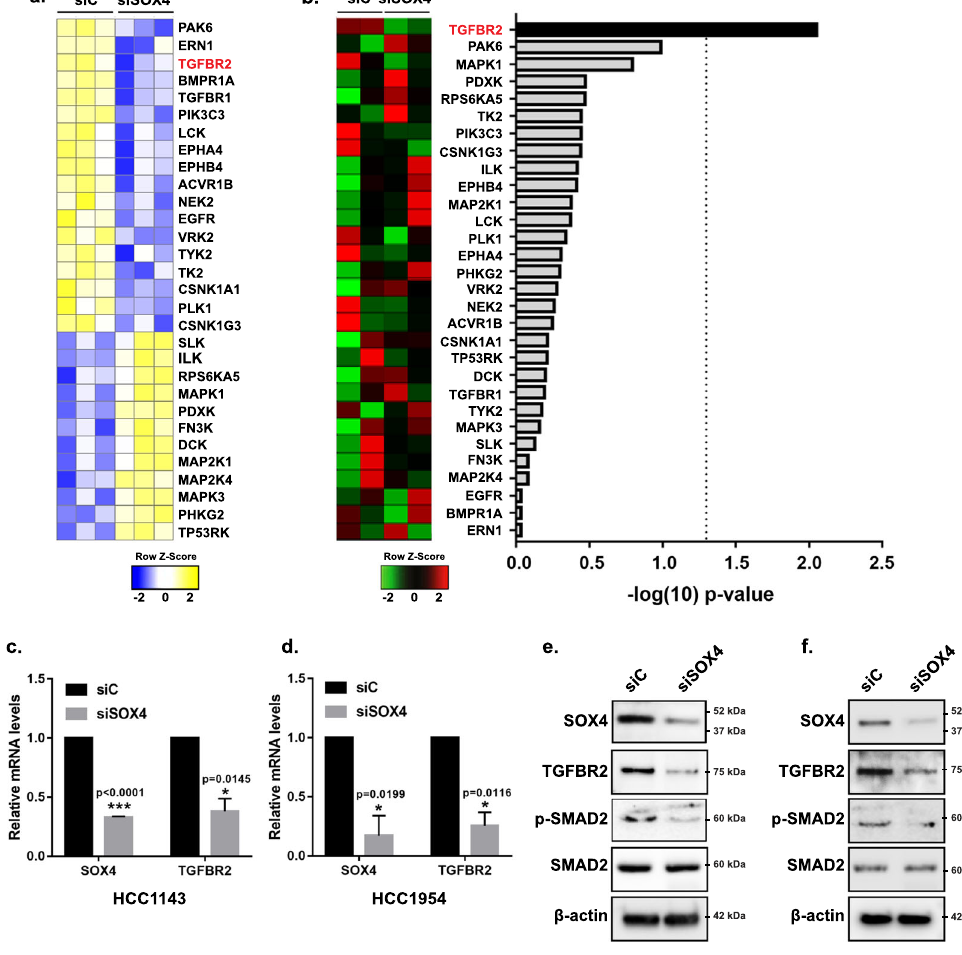
Fig. 2 TGFBR2 is a downstream target gene of SOX4. a Pro fi ling of the drug-able kinome by MIB/MS analysis in HCC1143 cells identi fi ed 18 kinases with signi fi cantly reduced expression and/or af fi nity for Type I kinase inhibitor bait ( p < 0.05) and 12 kinases with increased expression/ af fi nity following siRNA-mediated silencing of SOX4 ( n = 3, 96 h) relative to siControl-treated samples ( n = 3); kinase enrichment score is shown in yellow and kinase depletion score in blue. b Differential gene expression analyses of RNAseq data for the signi fi cantly altered kinases from MIB/MS analysis from siSOX4- and siControl-treated HCC1143 cells (96 h); high mRNA expression is shown in red and low expression in green. c HCC1143 and d HCC1954 cells demonstrate signi fi cant reduction (unpaired t-test) in SOX4 ( p < 0.0001; p = 0.019) and TGFBR2 ( p = 0.014; p = 0.012) expression in siSOX4-treated cells compared to siControl-treated cell by qRT-PCR; data are presented as mean ± SD and normalized for GAPDH ( n = 3). e HCC1143 and f HCC1954 cells showing reduced SOX4 and TGFBR2 protein expression by western blot analyses in siSOX4-treated cells relative to siControl-treated